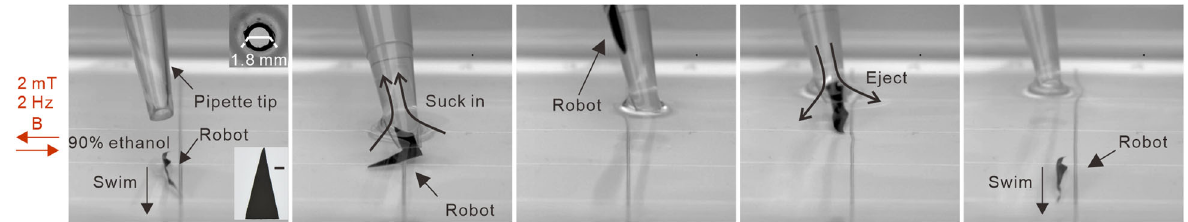
Fig. 5 Highly conformal ultrathin magnetic soft robots. A triangle-shaped magnetic soft robot (lateral dimensions: 12 × 5.8 mm 2 ; thickness 45 µ m) can be inserted in/released from a pipette tip with an opening of 1.8 mm in diameter. The magnetic manipulation allows the robot to minimize its cross-section, which enables its insertion into the pipette (Supplementary Movie 14). The robot is driven by a square wave magnetic fi eld (2 mT, 2 Hz). Scale bar, 2